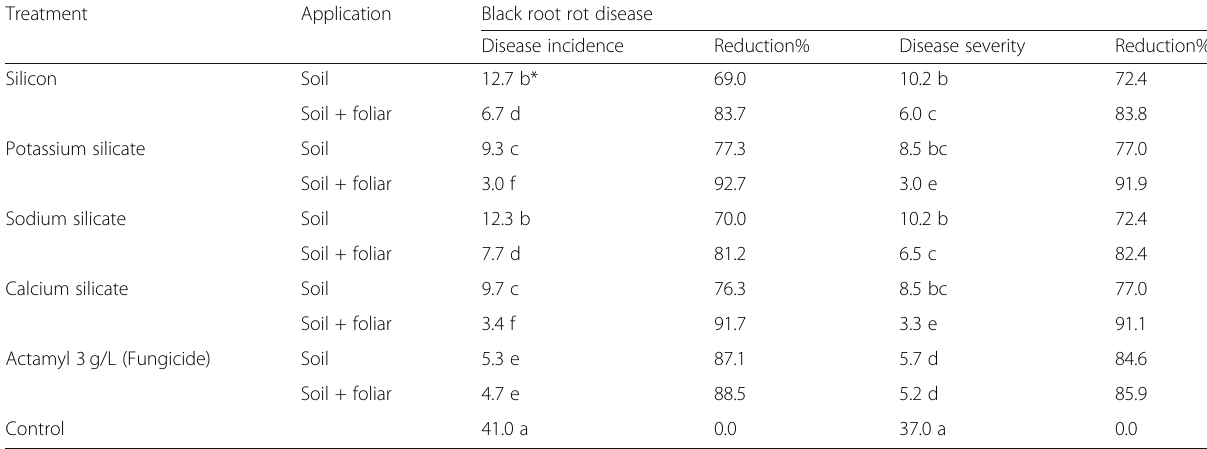
Table 2 Effect of silicon as well as potassium, sodium and calcium silicates on root rot disease incidence and severity of strawberry plants under field conditions